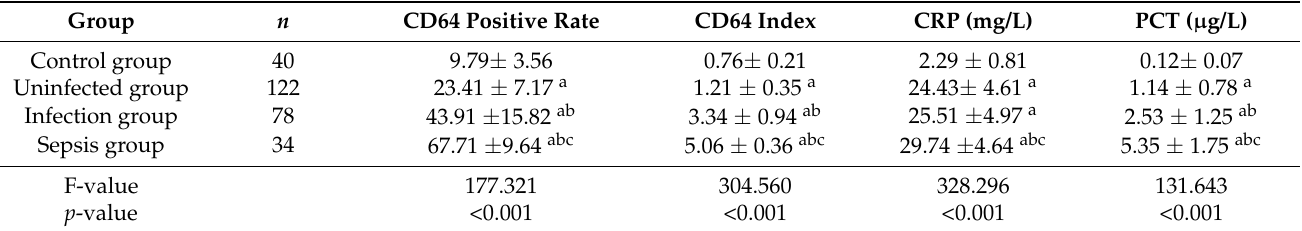
Table 2. Comparison of infection indexes in 4